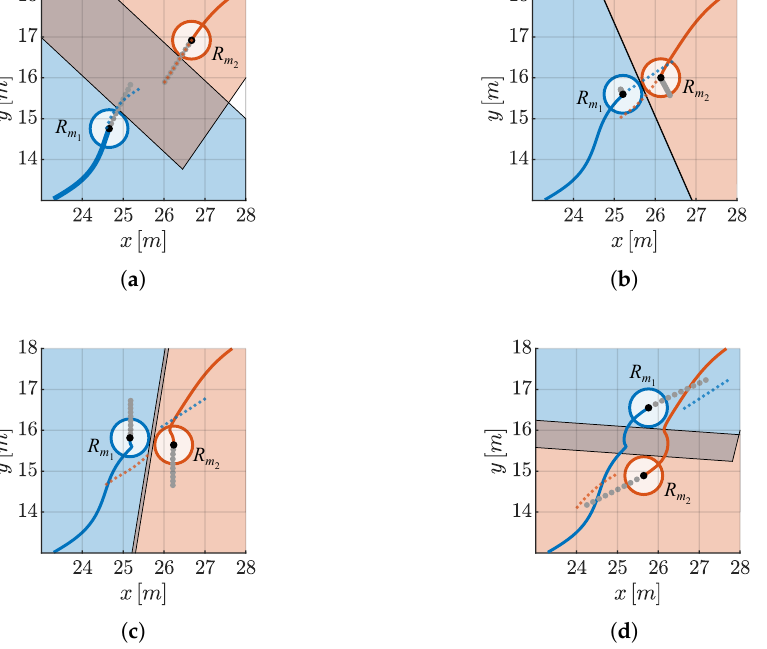
Figure 4. Detail of how the proposed algorithm avoids a crash between R m the predicted positions (grey dots), the desired trajectory (coloured dots), the travelled path (coloured line), and the allowed area (coloured polytope) are reported. R m respectively. ( a ) The desired trajectory of each robot lies within the allowed area, hence the obstacles constraints are inactive; ( b ) The predicted positions deviate from the desired paths to satisfy the obstacle constraints; ( c ) The two robots react to avoid a crash; ( d ) The two robots start to recover their desired